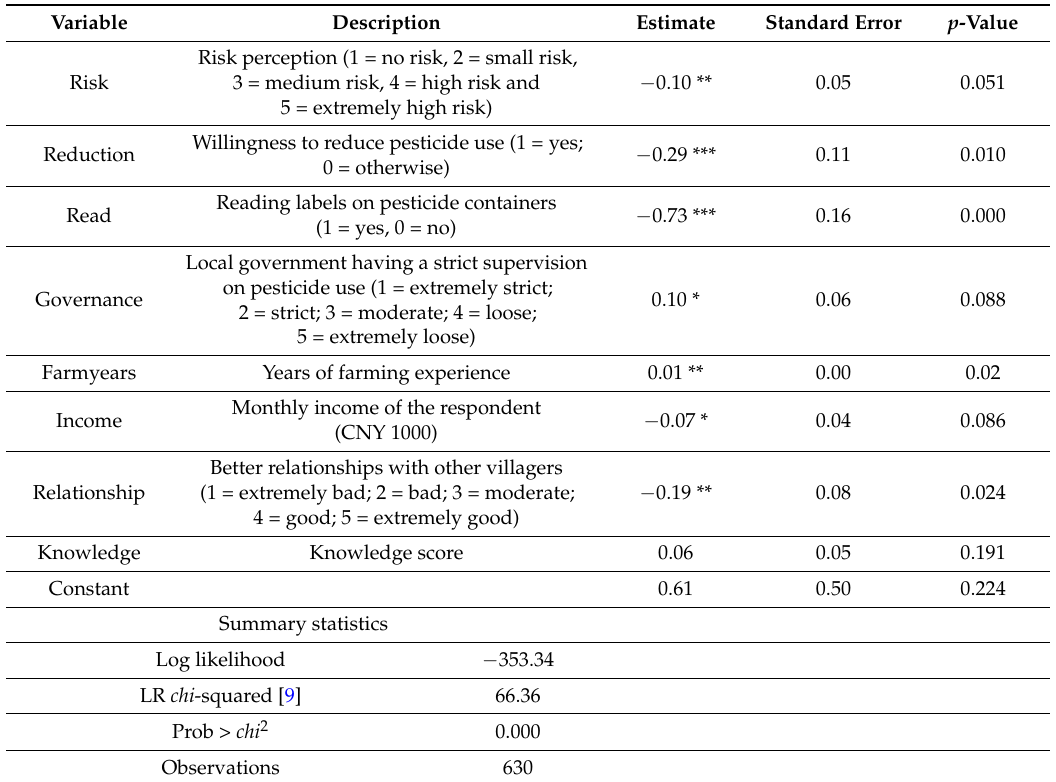
Table 5. Factors affecting farmers’ pesticide